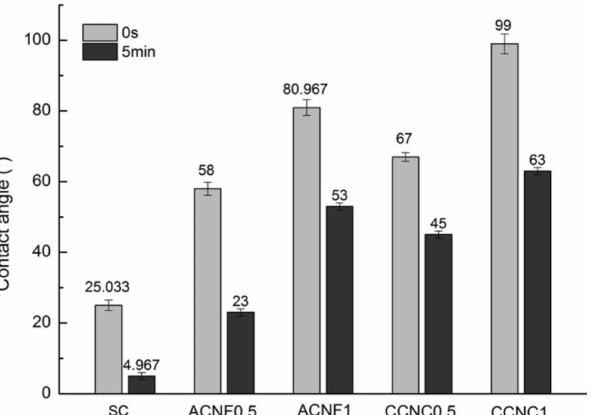
Figure 7. Contact angle of concrete specimens treated with different coatings, measured at time 0 and after 5 min from the application of the coating, in comparison to un-treated concrete (SC). Reprinted from [83], with permission from Elsevier (November,